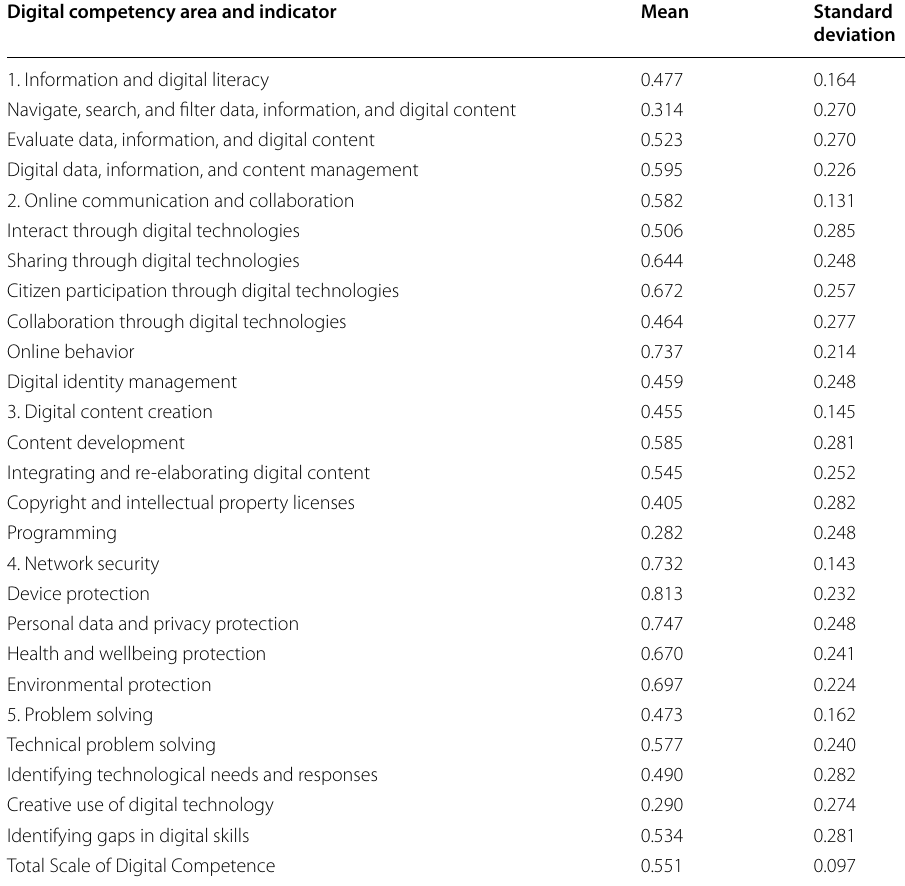
Table 3 Descriptive statistics for DigComp‑PED areas and indicators. Source: Prepared by the author Digital competency area and indicator Mean Standard